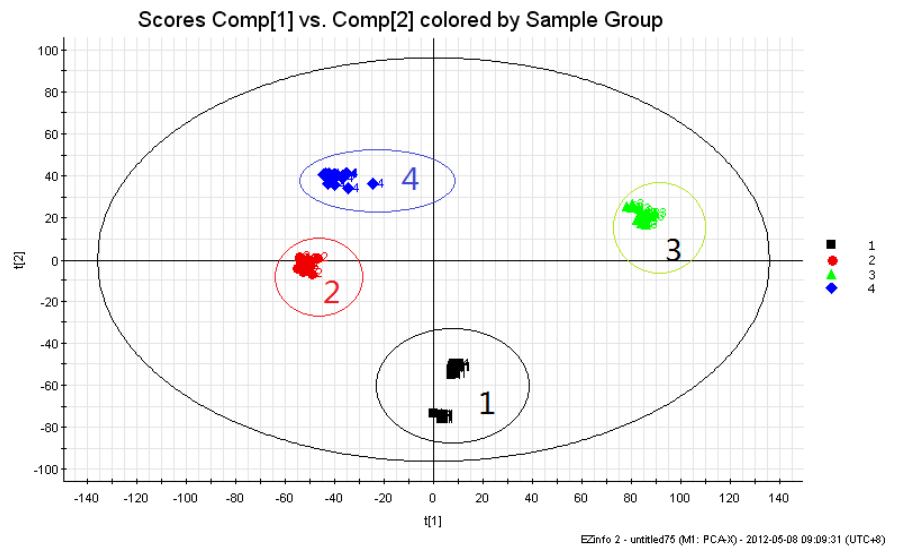
Figure 2. PCA score plot: ( 1 ) Radix Aconiti (RA); ( 2 ) Radix Aconiti Praeparata (RAP); ( 3 ) Radix Aconiti Kusnezoffii (RAK); and ( 4 ) Radix Aconiti Kusnezoffii Praeparata (RAKP).